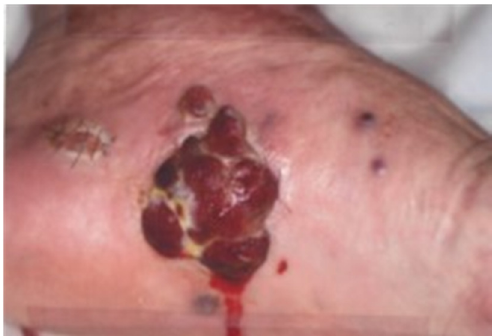
Figure 1. Physical examination indicated a 50 × 60 mm pedunculated red mass on the sole of the patient’s left foot.